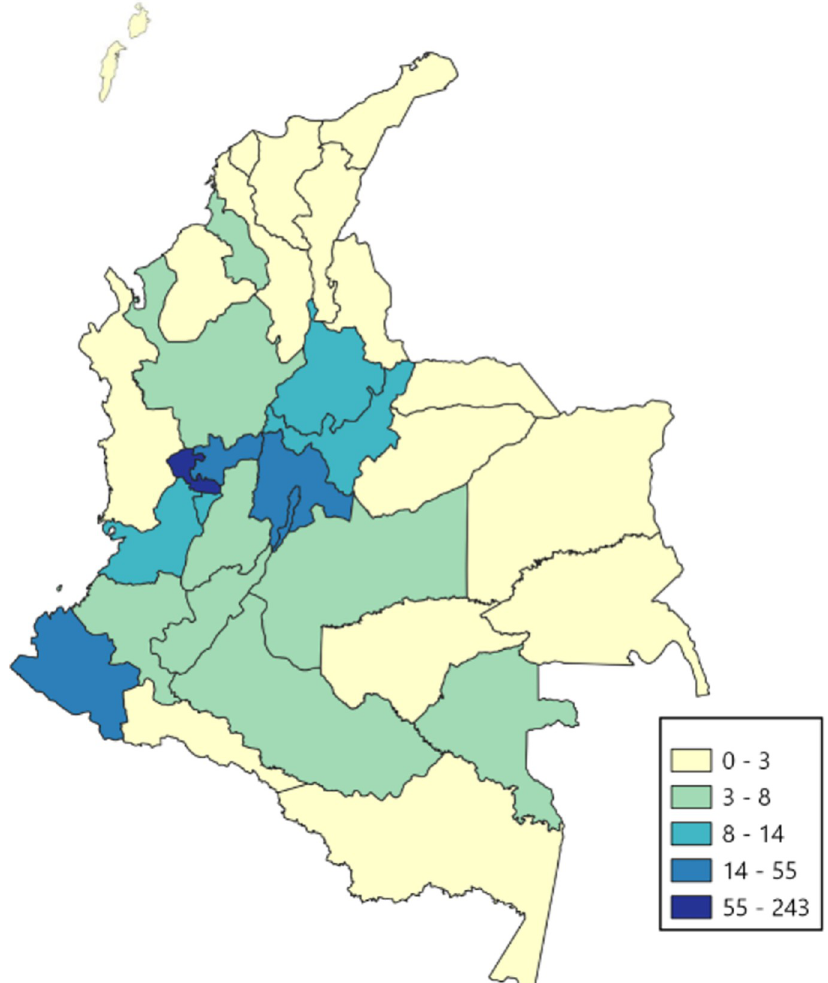
Fig 2. Prevalence of sleep apnea in children and adolescents by department, Colombia, 2019. “Elaborated by the authors. Map shapes/layers reprinted from https://www.datos.gov.co/Mapas-Nacionales/Departamentos-y- municipios-de-Colombia/xdk5-pm3f under a CC BY license, covered by Law 1712 of 2014 of the Colombian Ministry of Information and Communication Technologies, 2022”.